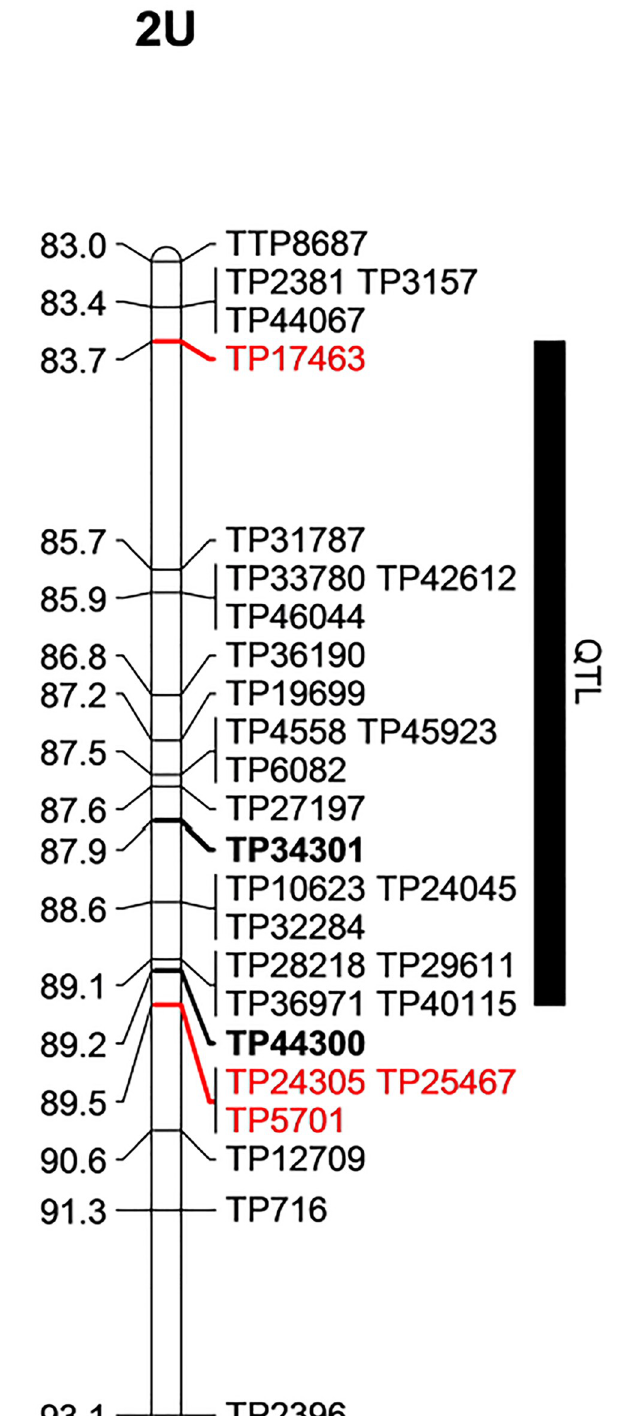
Fig 2. Stem resistance QTL region mapped from two Ae . umbellulata bi-parental populations.